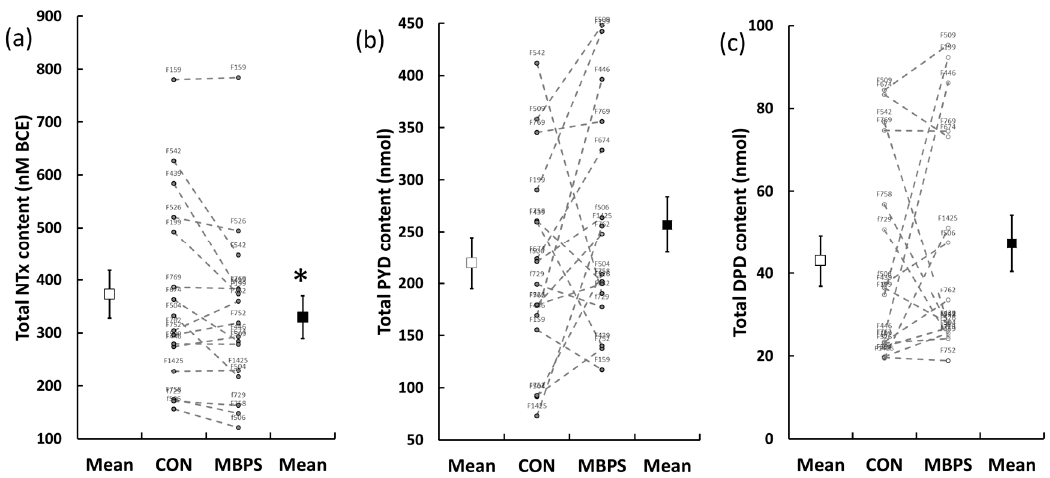
Figure 5. Individual and mean 24-h urinary excretion of urinary biomarker of bone turnover in the CON (open circles) and MBPM (filled circles): ( a ) total NTX, ( b ) total PYD, and ( c ) total DPD. Data are the mean and SEM, n = 16; * denotes p < 0.05. Alphanumeric numbers identify individual subjects’ response.